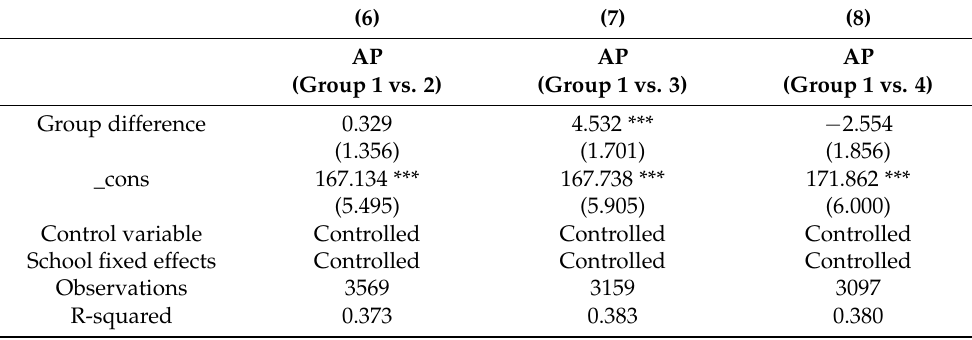
Table 4. Comparison of extracurricular tuition effects with different